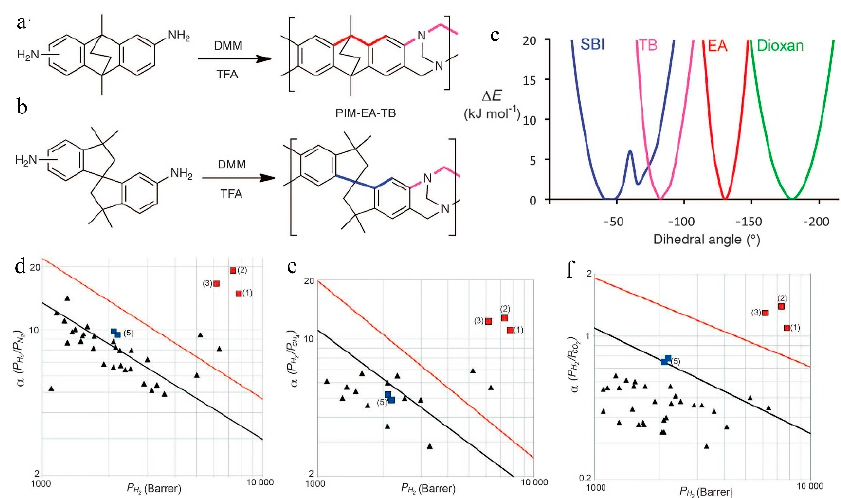
Figure 5. The synthesis and molecular structures of ( a ) PIM-EA-TB, ( b ) PIM-SBI-TB (DMM, dimethoxymethane, TFA, trifluoroacetic acid), ( c ) A plot showing the increase in energy associated with the deviation in the marked dihedral angle within the bridged bicyclic units of EA (red) and TB (purple) as compared with typical components of PIMs, such as the spiro-center of SBI (blue) and the dioxan linking unit (green). The narrower energy wells of the bridged bicyclic units TB and EA demonstrate their greater rigidity. Portions of the Robeson plots relevant to highly permeable polymers for ( d ) H 2 /N 2 , ( e ) H 2 /CH 4 , ( f ) H 2 /CO 2 gas pairs showing the data for methanol-treated PIM-EA-TB, with data points 1 (solid red square) for a 181 mm film, 2 (solid red square) for a 95 mm film, and 3 (solid red square) for the same 181 mm film after aging for 24 h. The black and red lines represent the 1991 and 2008 upper bounds, respectively. Data points 5 (solid blue squares) are from 157 and 128 mm films of PIM-SBI-TB. Other data points (solid black triangles) represent PIMs and other highly permeable polymers that have been reported since the upper bounds were updated in 2008. Adapted from Reference [51].